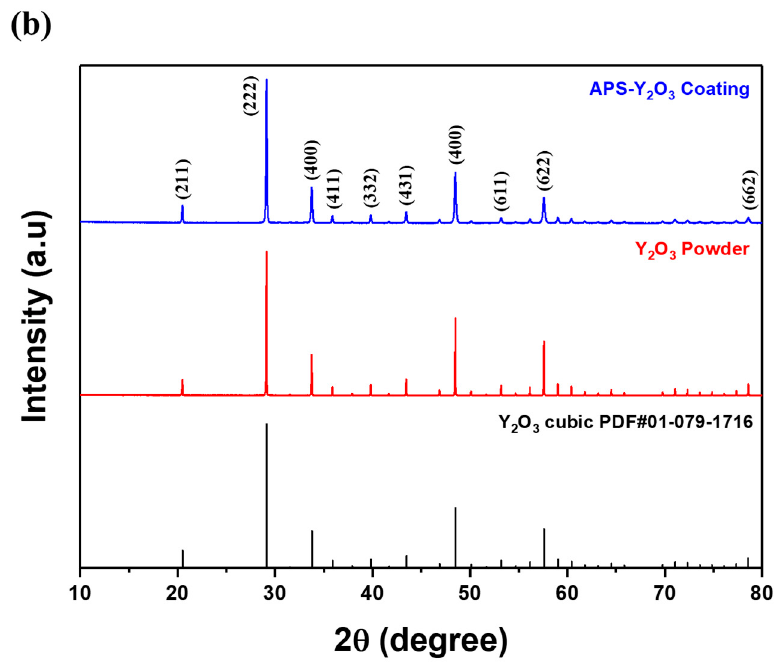
Figure 1. ( a ) Powder size analysis of the Y 2 O 3 coating, ( b ) XRD patterns of Y 2 O 3 powder and APS–Y 2 O 3 coating.